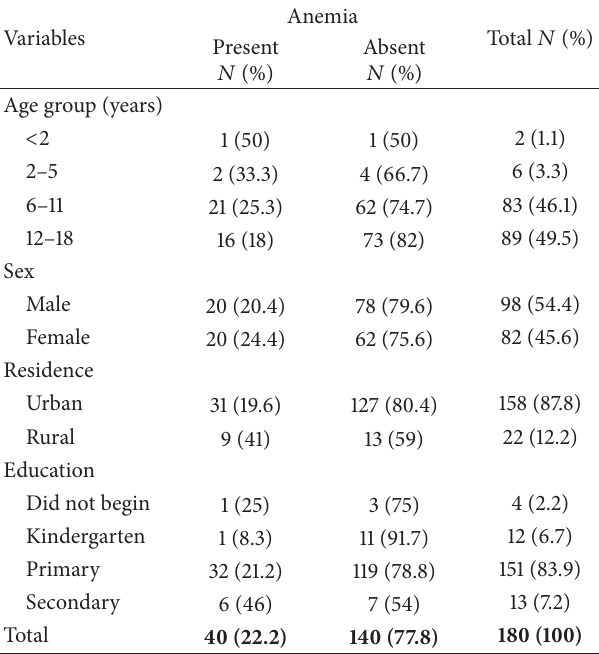
Table 1: Sociodemographic characteristics of pediatric HIV/AIDS patients attending Zewditu Memorial Hospital from August 5, 2013, to November 25, 2013, Addis Ababa, Ethiopia ( 𝑁 = 180 ).